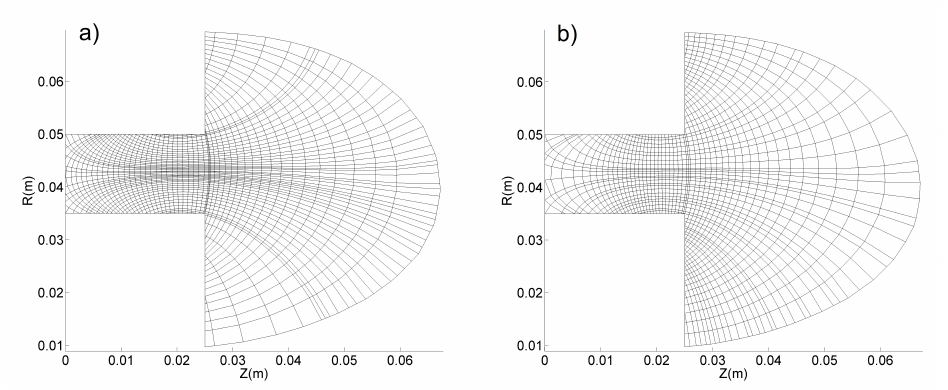
Figure 9. Meshing examples obtained with two methods for an initial number of λ and σ isolines equal to 50: ( a ) Smoothing method; ( b ) Expanded Exponential Stretching method & manual